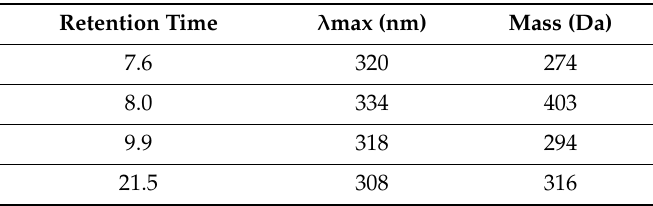
Table 3. Absorption maxima and molecular mass of unidentified compounds, most likely MAAs, in the extracts of Bostrychia